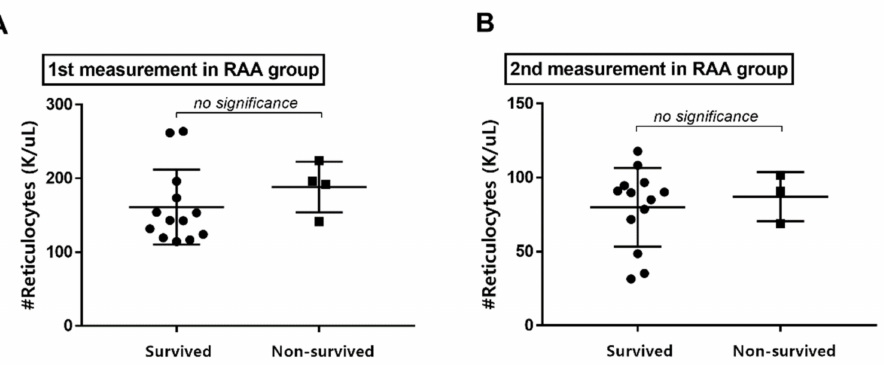
Figure 4. Absolute reticulocyte count in the survived and non-survived dogs in the RAA group. At both ( A ) the first and ( B ) the second measurements, there were no significant differences in absolute reticulocyte count between survived and non-survived groups. RAA: reticulocytosis in the absence of